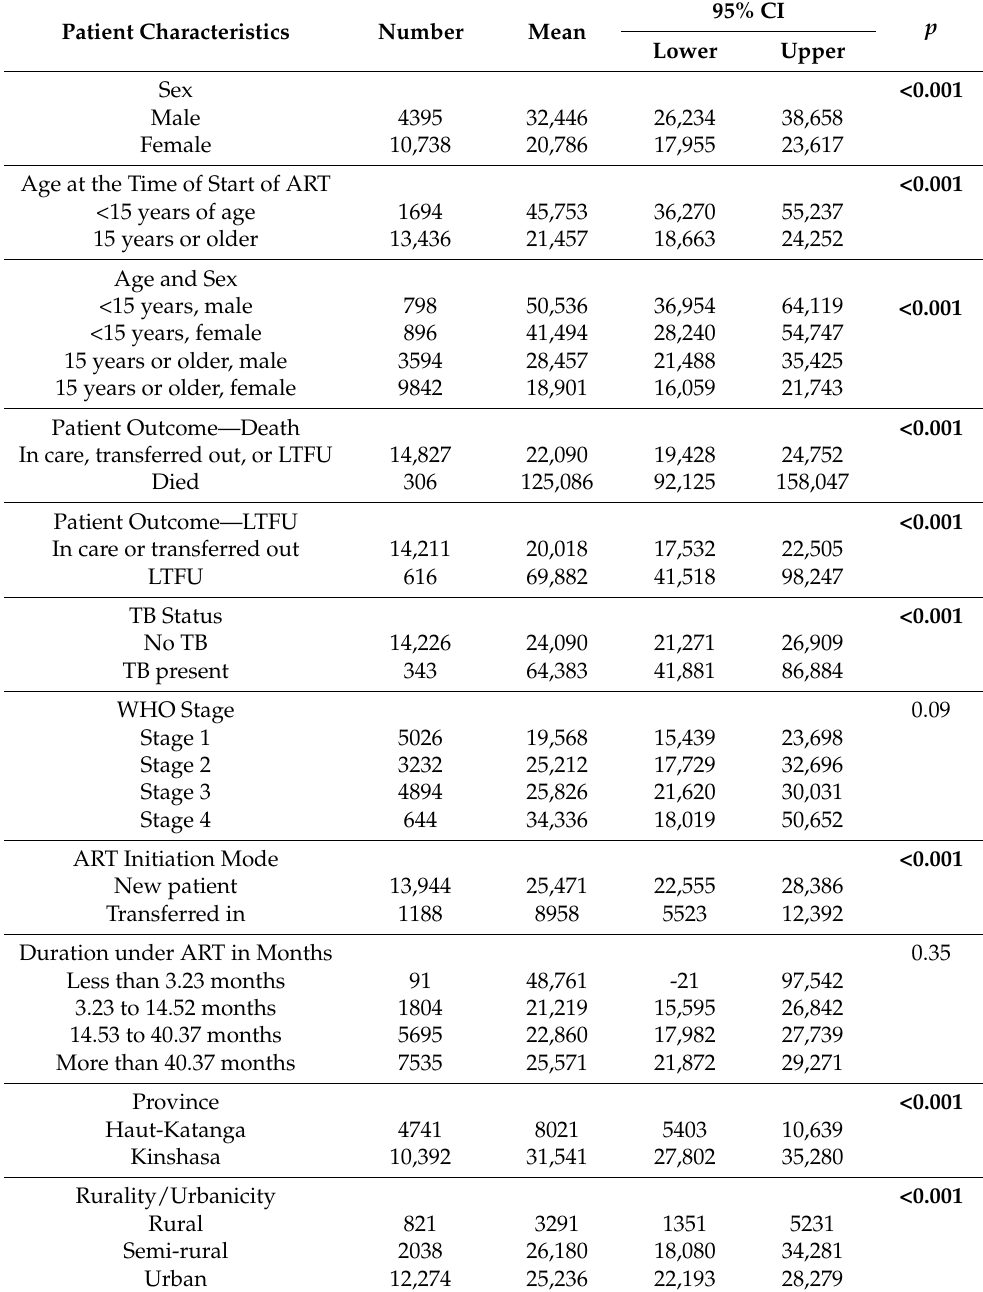
Table 2. Analysis of variance (ANOVA) results for the association of characteristics of patients with viral load in HIV/AIDS clinics of Haut-Katanga and Kinshasa provinces, DRC, 2014–2019. Patient